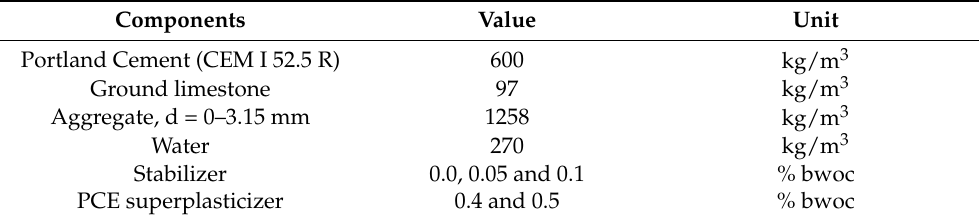
Table 2. Mixture composition of the fine grained sprayed concrete.